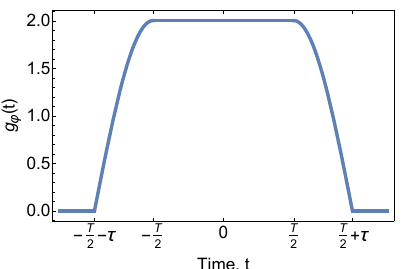
Figure 9. Sensitivity function for RF phase